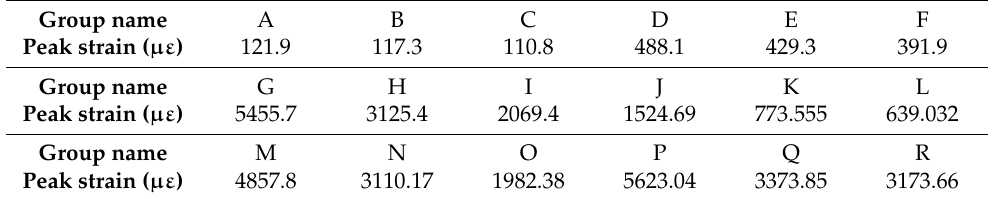
Table 11. Peak strain of the BFRP bars on the vault under various working conditions.